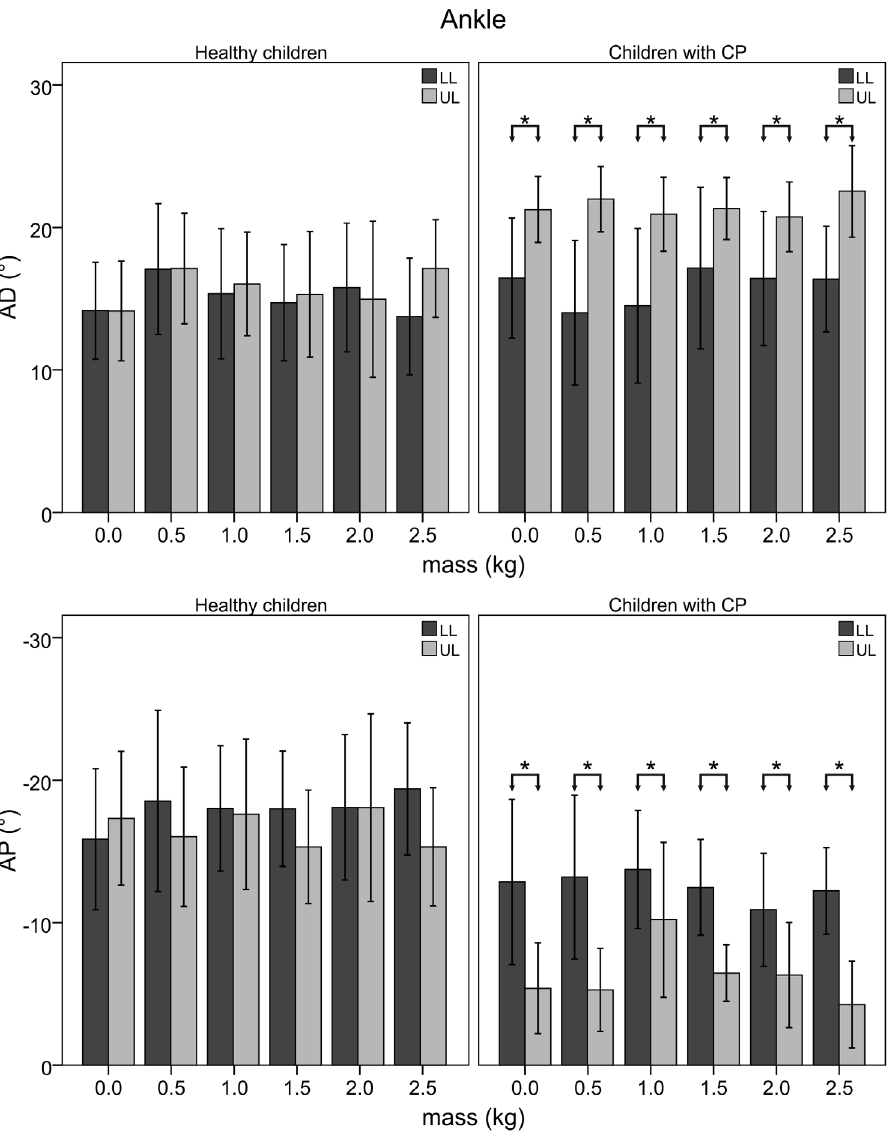
Figure 3. Peaks of ankle angle of loaded and unloaded leg. Mean and standard deviation for peak values of ankle dorsiflexion (AD) and plantarflexion (AP) angles of loaded (LL) and unloaded (UL) leg for healthy children and those with CP as a function of the added mass value. Asterisks indicate significant differences.